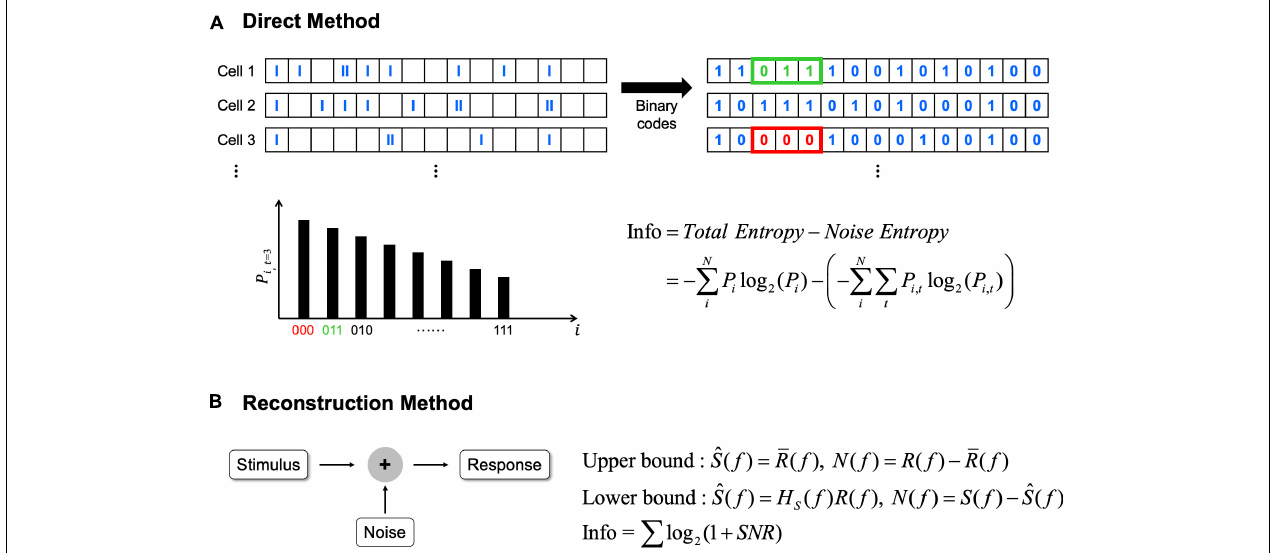
FIGURE 2 | The direct method and the reconstruction method can be applied to calculate information rates. (A) In the direct method, average information rates are the difference between total entropy and noise entropy. N represents the total number of possible binary code combinations, i represents binary code combination. P i indicates probability of particular binary code combinations and similarly P i , t indicates the probability of particular binary code combinations at a specific time, t . (B) In the reconstruction method, average information rates are obtained from the signal to noise ratio (SNR). Signal and noise are calculated differently in each bound (see Passaglia and Troy, 2004 for how signal and noise are calculated). In here, S(f) means signals which are the Fourier transforms of the stimulus, R(f) means responses which are also the Fourier transforms of the response, respectively. ˆS(f) means the best estimate of stimulus. In upper bound, ˆS(f) is obtained by averaging R(f) [i.e,. ¯R(f) ]. In lower bound, ˆS(f) is obtained by the linear decoder filter, H s (f) . N(f) represents noise, and noise is also different in each bound. In upper bound, noise is the difference between response and average response, while noise is the difference between signals and estimated stimulus in lower